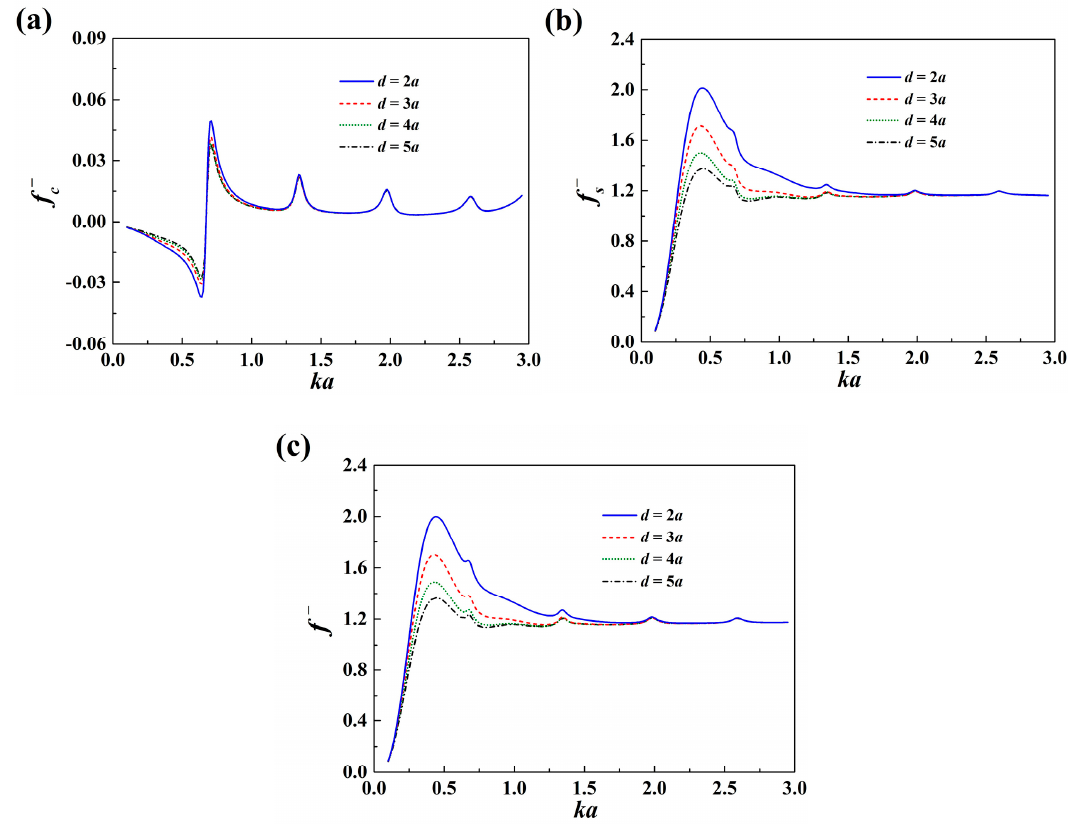
Figure 5. Effect of the water depth on the mean drift wave force on the interior column, the exterior porous shell, and the system ( G 0 = 0.05 and b = 2 a ): ( a ) f − c ( b ) f − s ( c ) f −